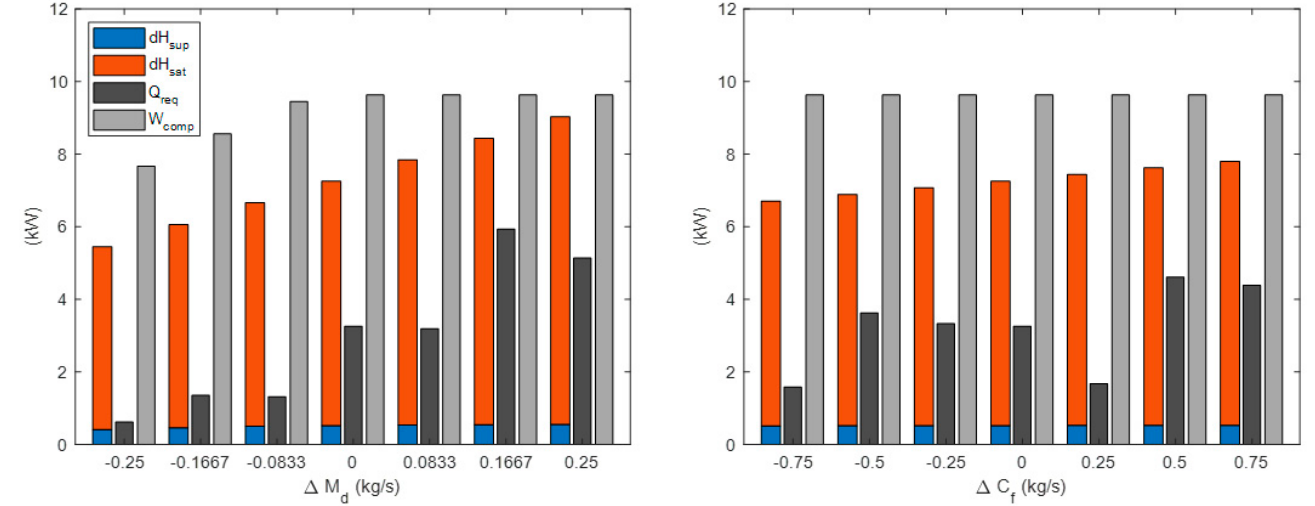
Figure 5. Sensitivity analysis results for M d ( left ) and C f ( right